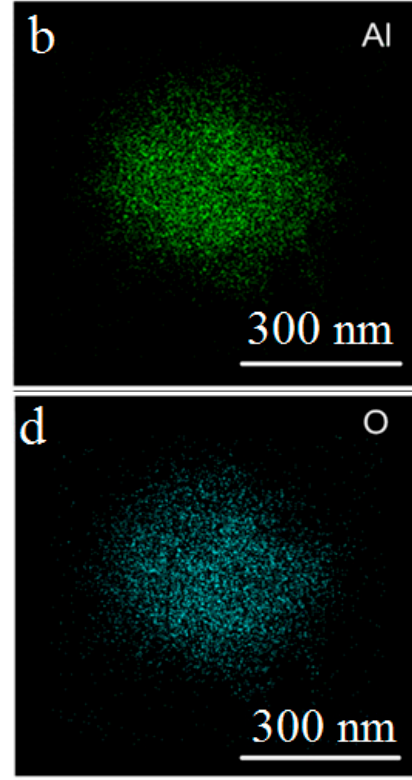
Figure 3. TEM image ( a ) and TEM-EDS mapping ( b – d ) of the nanoscale structures obtained through the water oxidation of Al/Ag nanoparticles at 60 ° С (sample 1).